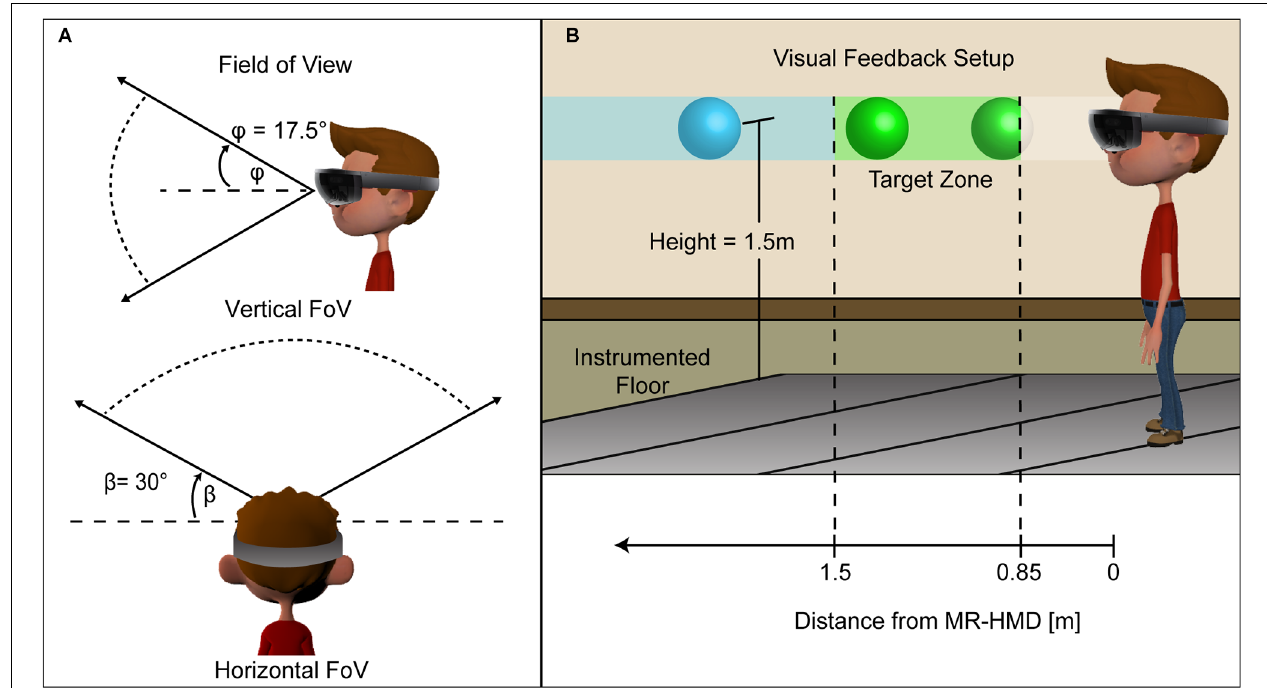
FIGURE 1 | Visualization of the HoloLens MR-HMD. The image on the left (A) shows the vertical and horizontal field of view for rendered holographic objects. The visual feedback (B) consisted of a floating holographic ball in different sections based on distance from the HMD. When maintaining the target speed, the ball remains between 1.5 m and 0.85 m from the subject and is colored green. If the subject walked too slowly and the ball was beyond 1.5 m its color changed to blue providing additional feedback that the user should walk faster. The ball clipped when it was less than 0.85 m from the HMD indicating that the subject should walk more slowly.